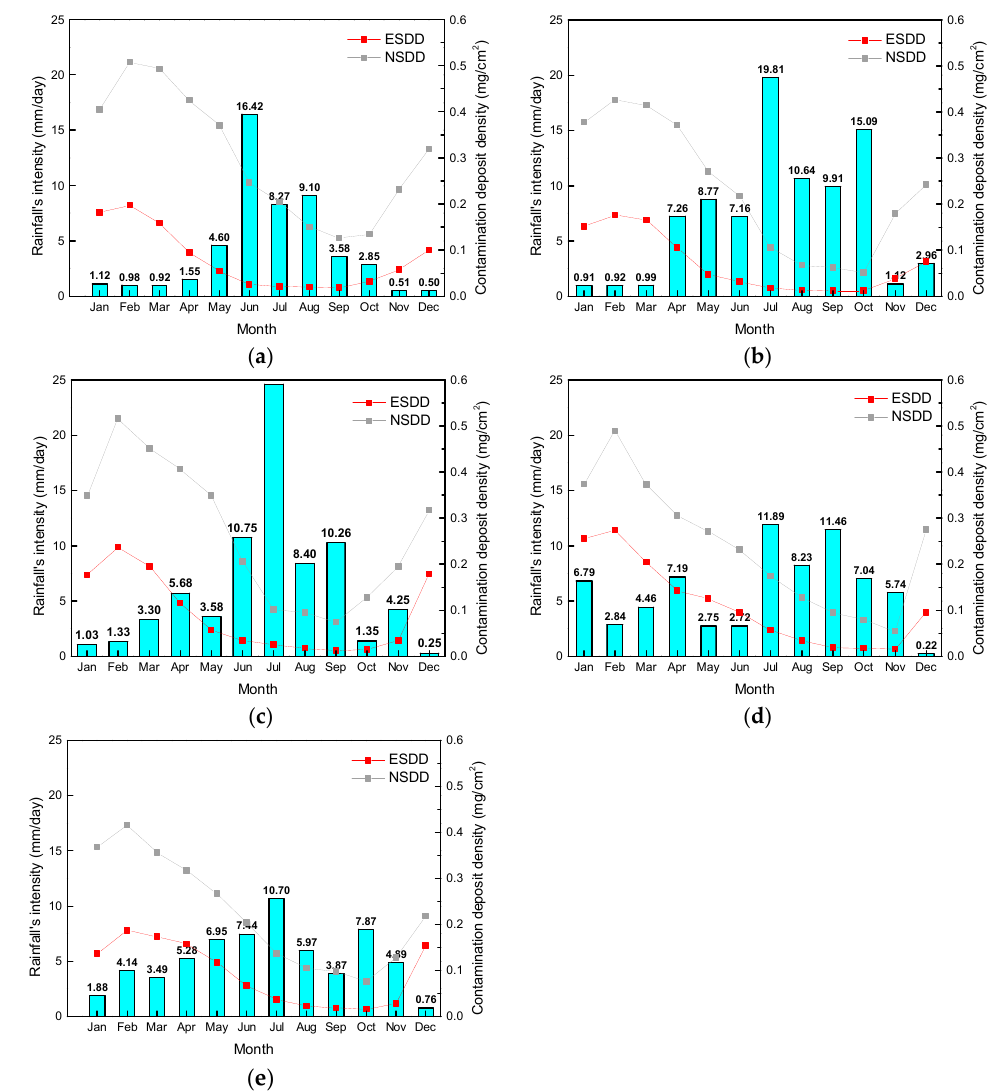
Figure 4. Averaged monthly rainfall intensities and corresponding contamination deposit densities for each year ( a ) 2011; ( b ) 2012; ( c ) 2013; ( d ) 2014 and ( e ) 2015 in the test period (He-Yun Line).